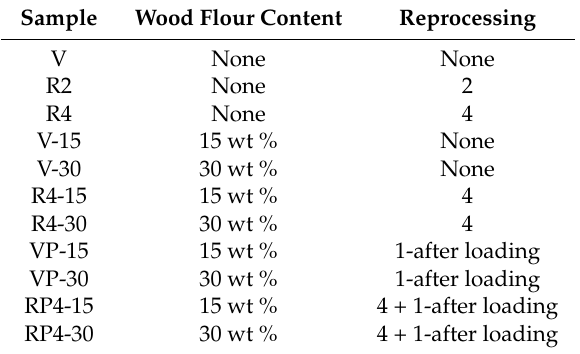
Table 8. Sample code, formulation, and processing